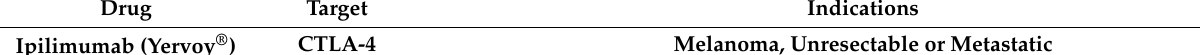
Table 1. FDA-approved immune checkpoint inhibitors and their specific clinical indications. Ipilimumab is the only FDA-approved anti-CTLA-4 monoclonal antibody. ALK, anaplastic lymphoma kinase. BRAF, B-Raf proto-oncogene. CTL-4, cytotoxic T lymphocyte-associated antigen 4. CRC, colorectal cancer. dMMR, mismatch repair deficient.